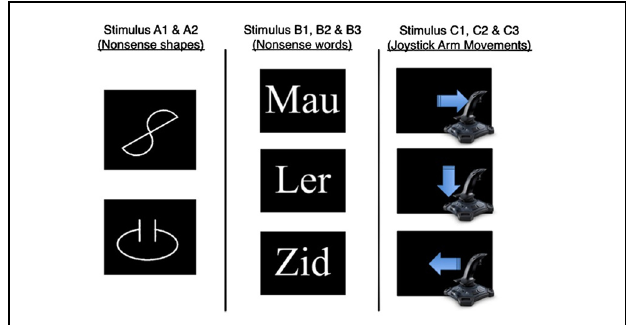
FIGURE 1 | An overview of the shapes (A1 and A2), nonsense words (B1, B2, and B3) and joystick arm movements (C1, C2, and C3) that were used to establish two separate stimulus equivalence categories (A1 = B1 = C1 and A2 = B2 =